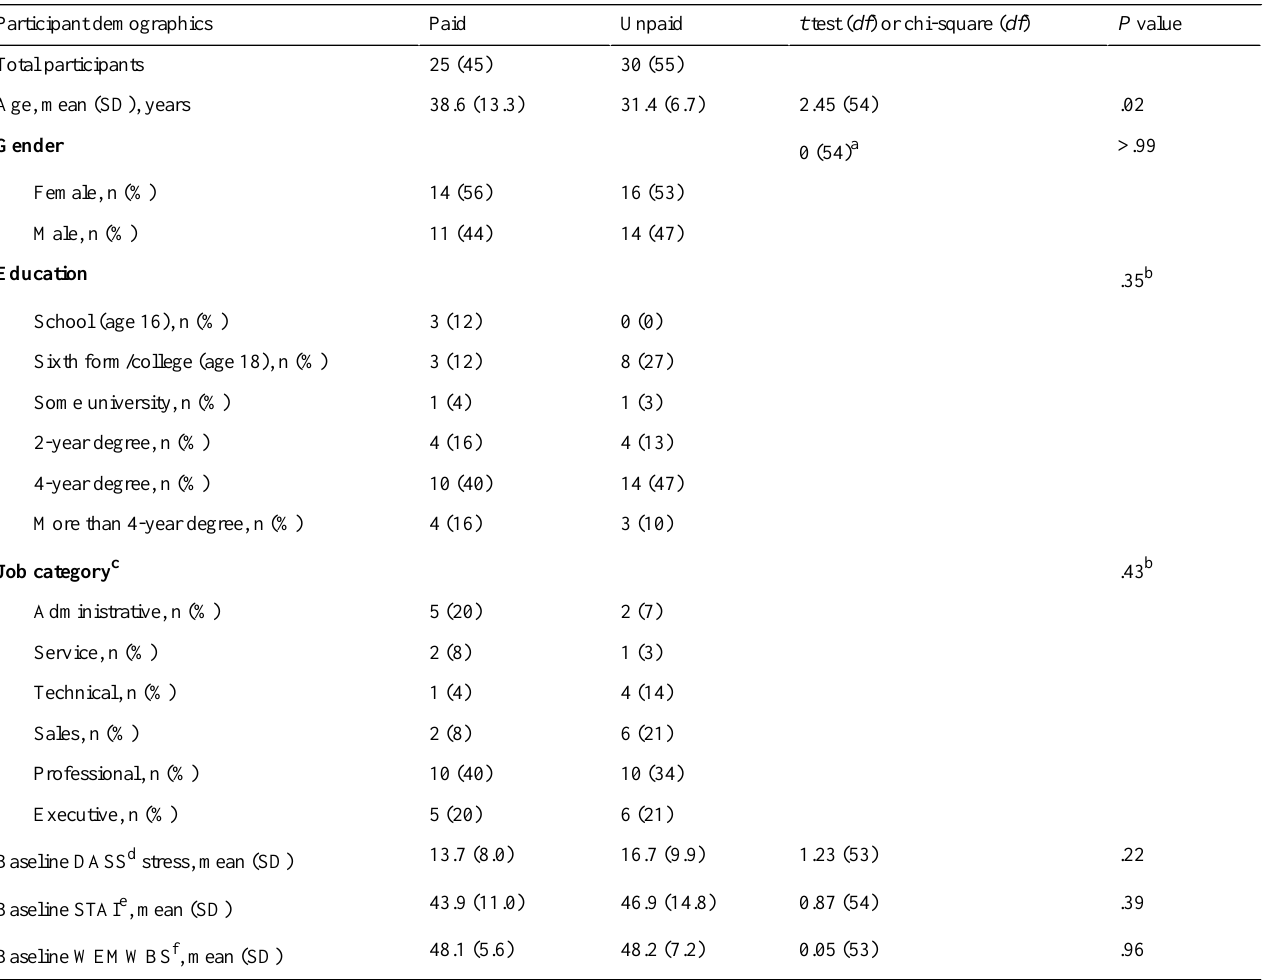
Table 1. Sample demographics of participants with baseline self-reported stress on DASS